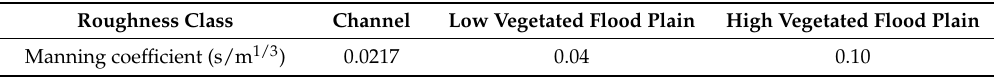
Table 1. Manning coefficients assigned to each roughness class.